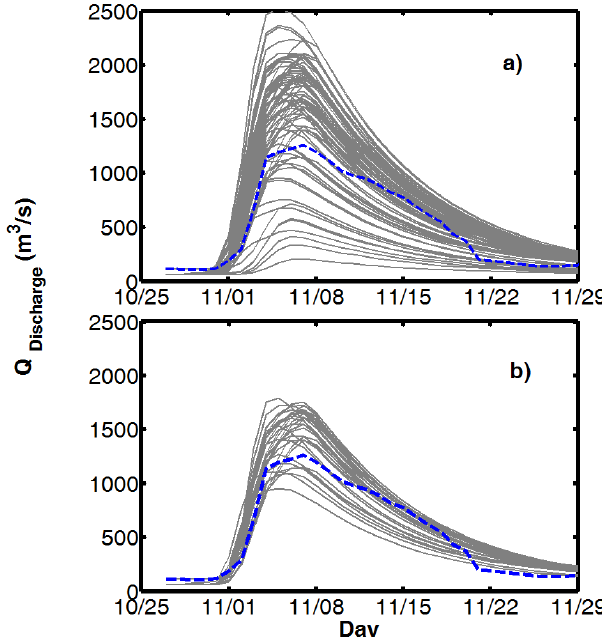
Figure 6. (a) 72 hydrographs computed using the rainfall–runoff model with six sets of parameters and 12 WRF ensemble precipi- tation fields as input data; (b) 31 selected hydrographs to serve as input in the hydrodynamic model; grey lines illustrate the ensemble members and the blue dashed line shows the measured river dis- charge for the